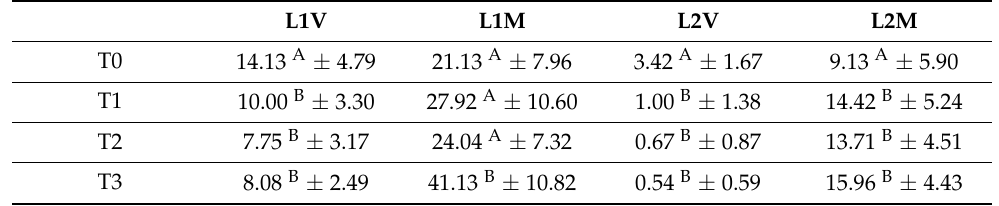
Table 2. Survival (V) and mortality (M) of Parlatoria ziziphi larvae (L1,L2) treated with different